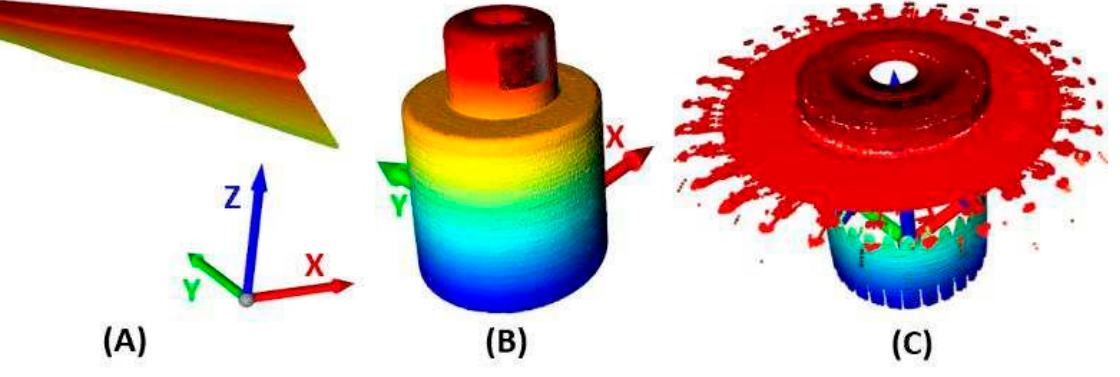
Figure 14. Illustration of application laser sensor in inspection gear wheel, where ( A ) is a raw point cloud of the scanned shaft, ( B ) is performed calibration for data of scanned shaft, and ( C ) is a processed scan of gear wheel according to calibration.